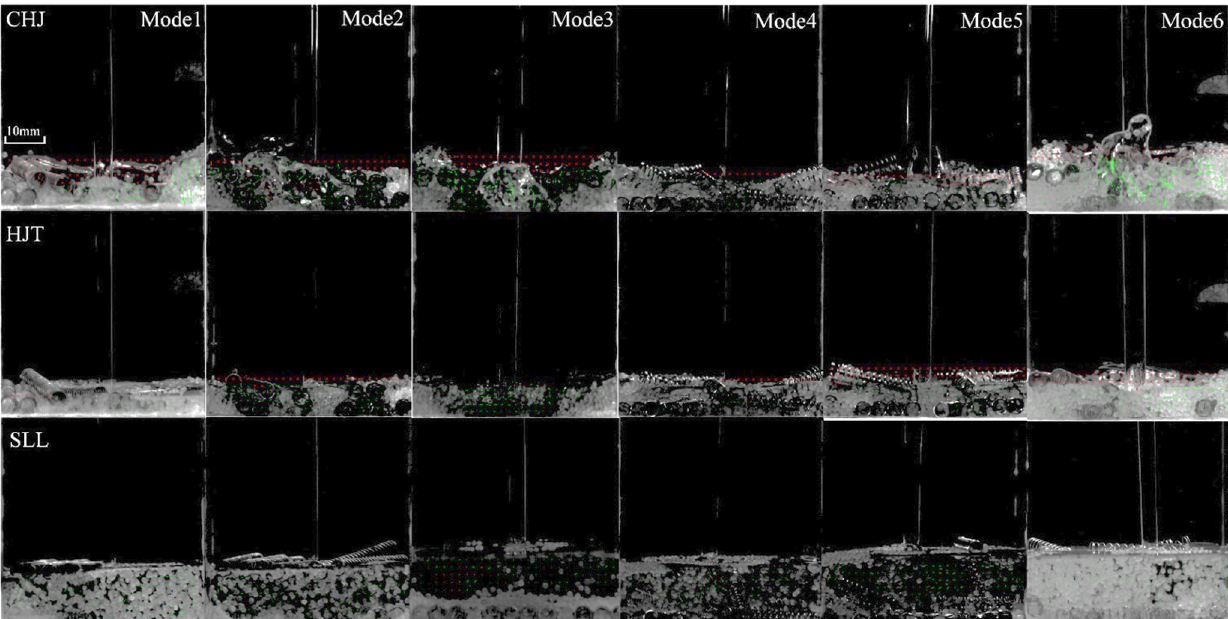
Figure 5. The hydraulic jump form and flow field in three physical forms of the hydraulic jump of front view. (casting speed of 0.8 m/min, modes 1–6).